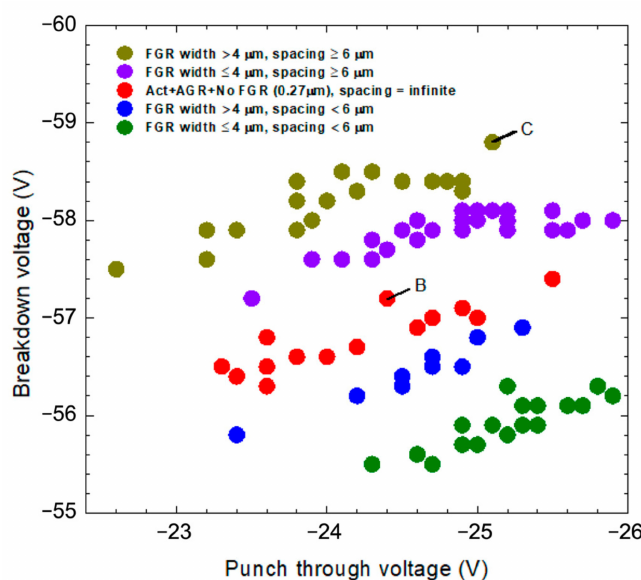
Figure 6. Breakdown voltage and punch-through voltage distribution for devices with different FGR structures. The red circle marked “B,” and the olive-green circle marked “C,” represent devices B and C, respectively, in Figure